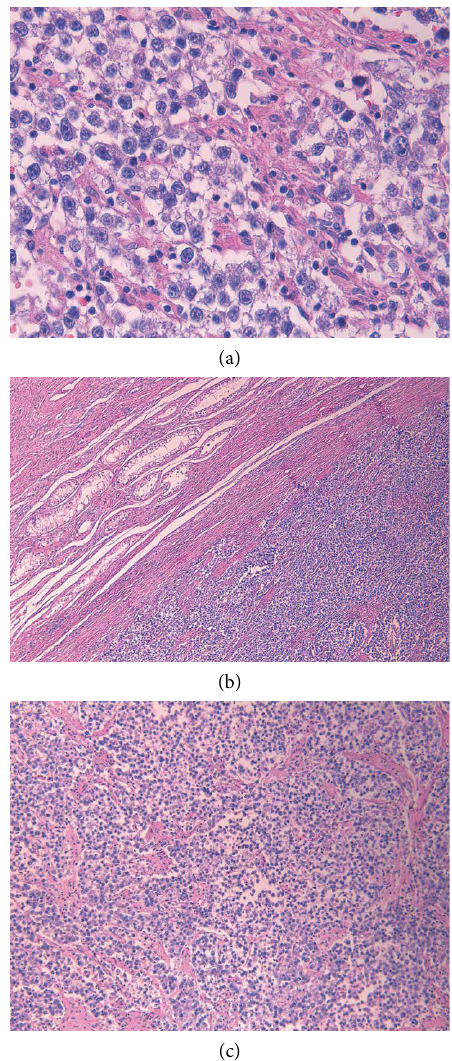
Figure 2: (a): High-power view shows round to polyhedral cells with distinct cell borders, and sparse lymphocytic infiltrate within fibrous septa, (b): Low-power view of the tumor (right) with background intratubular germ cell neoplasia (upper left), (c): Medium-power view of the tumor shows sheets of uniform clear cells divided into poorly demarcated lobules by delicate fibrous